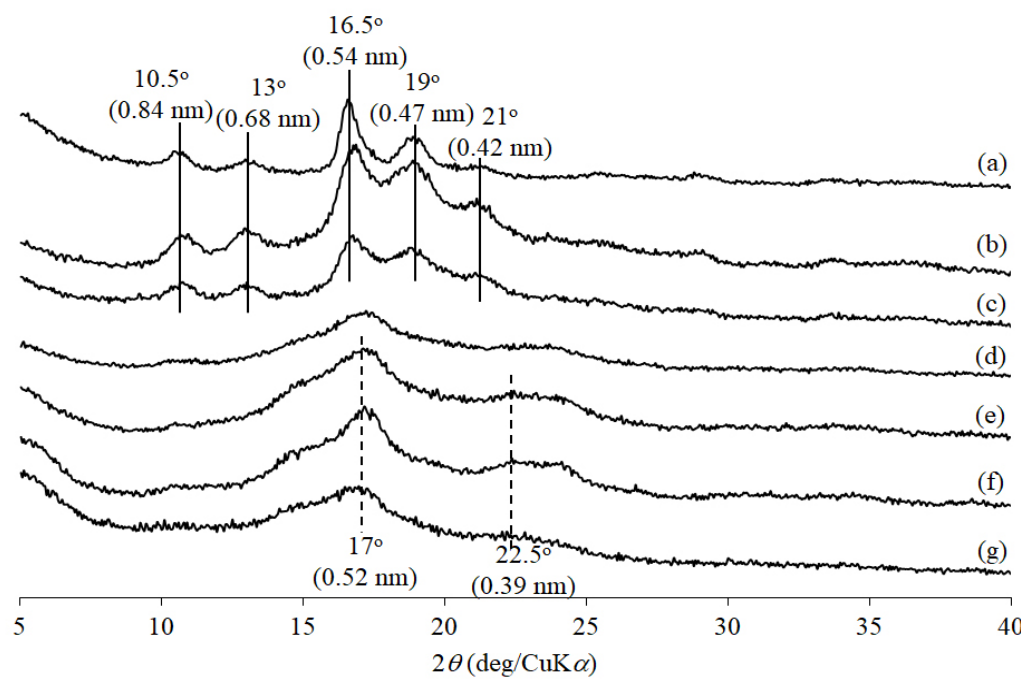
Figure 3. XRD profiles of ( a ) 2-deoxyamylose (entry 1), ( b – f ) partially 2-deoxygenated amyloses (entries 2–6), and ( g ) amylose.